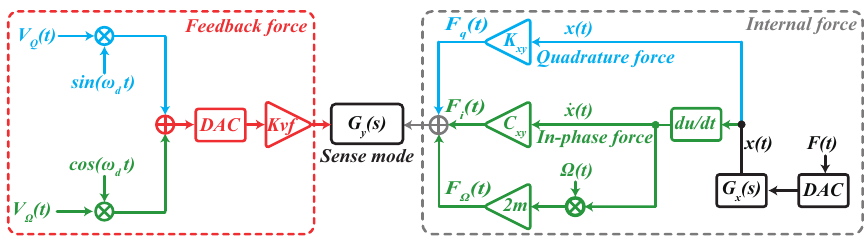
Figure 3. The force component analysis in sense